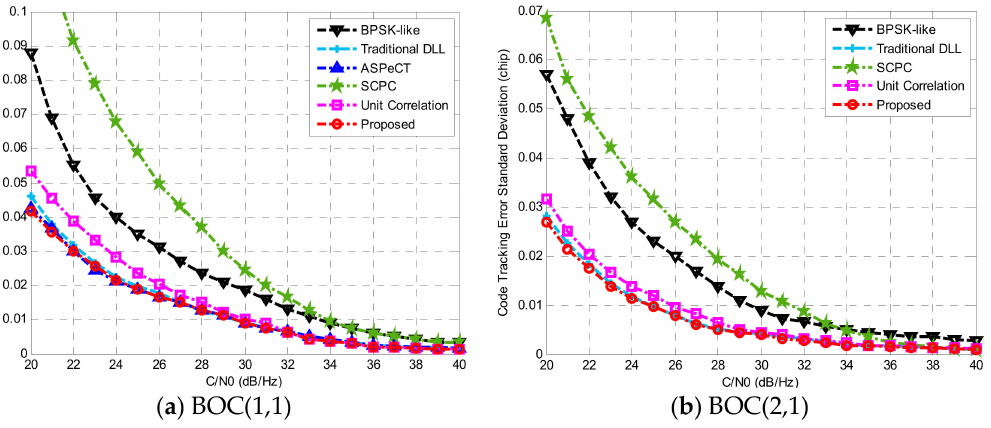
Figure 17. Code tracking error standard